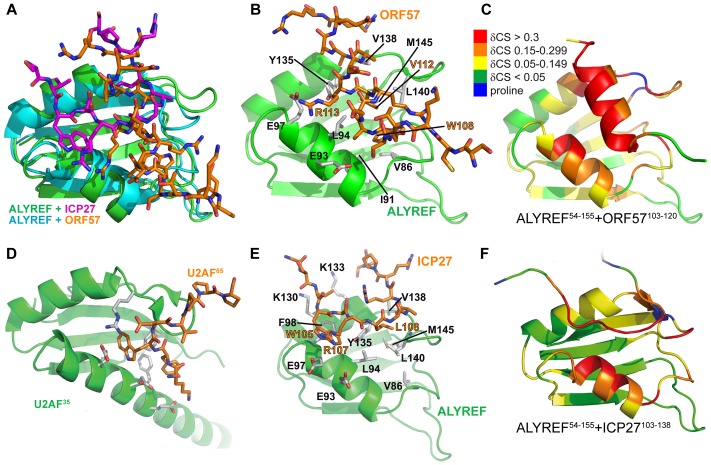
Comparison of ALYREF54–155-ORF57103–120 with ALYREF54–155-ICP27103–138 and U2AF complex structures.(A) Overlay of the RRM domains of ALYREF in complex with ICP27103–138 (green and magenta, PDB code 2kt5 [30]) and ORF57-bound ALYREF determined here (cyan and orange), demonstrating the shift in α-helix 1 position. (B) ALYREF54–155 in complex with ORF57103–120, determined here. (C) Backbone amide weighted chemical shift changes (δCS) in the ALYREF54–155-ORF57103–120 complex are emphasized by color. δCS>0.3 are red, 0.15–0.299 orange, 0.05–0.149 yellow, prolines are blue and regions unaffected are green. (D) U2AF35 in complex with U2AF65 (PDB code 1jmt, [50]). (E) ALYREF54–155 in complex with ICP27103–138, previously determined (pdb 2kt5). (F) Backbone amide weighted chemical shift changes (δCS) in the ALYREF54–155-ICP27103–120 complex with the same coloring as panel C.